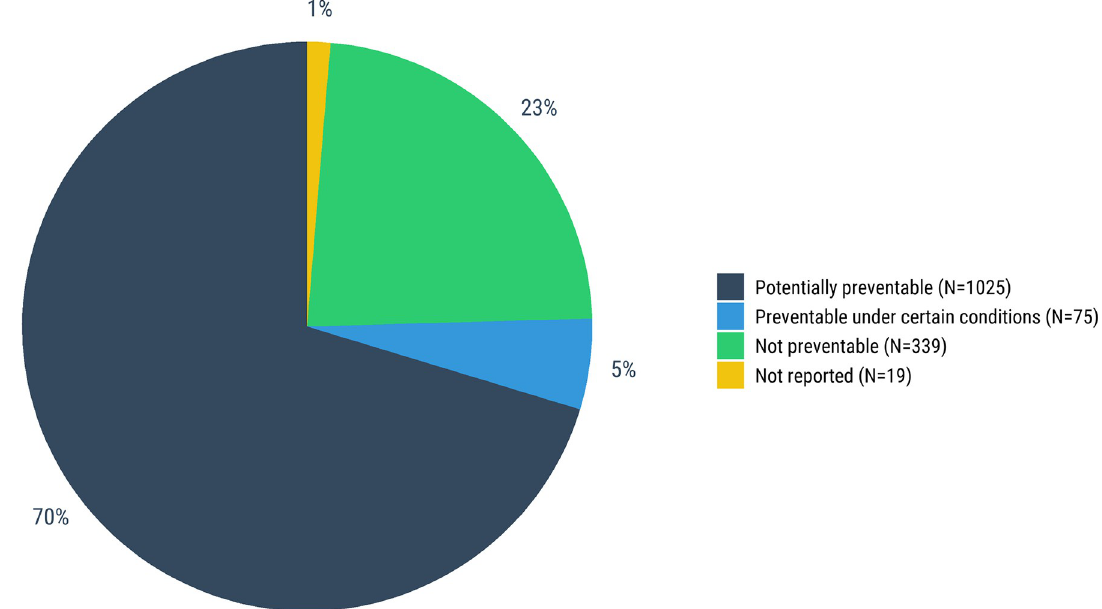
Fig 9. Expert (DeCoDe) panel determination of whether neonatal deaths were preventable (Fig 9) and recommended improvements that could prevent such deaths (Fig 10).